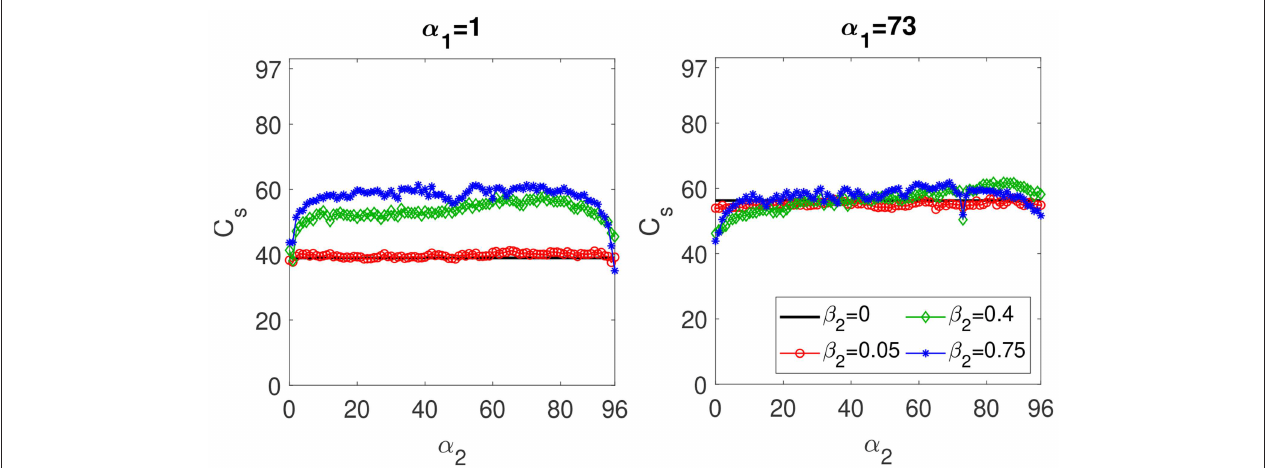
FIGURE 5 | C s of the two-delay-based RC as function of α 2 . Left : α 1 = 1. Right : α 1 = 73. The solid black line is the value of C s for the one-delay case with α = α 1 . Red circles, green diamonds and blue starts correspond to the C s with two delays and a β 2 of 0.05, 0.4, and 0.75, respectively. These results are obtained for T = θ/ 0.2 and γ = 0.1.